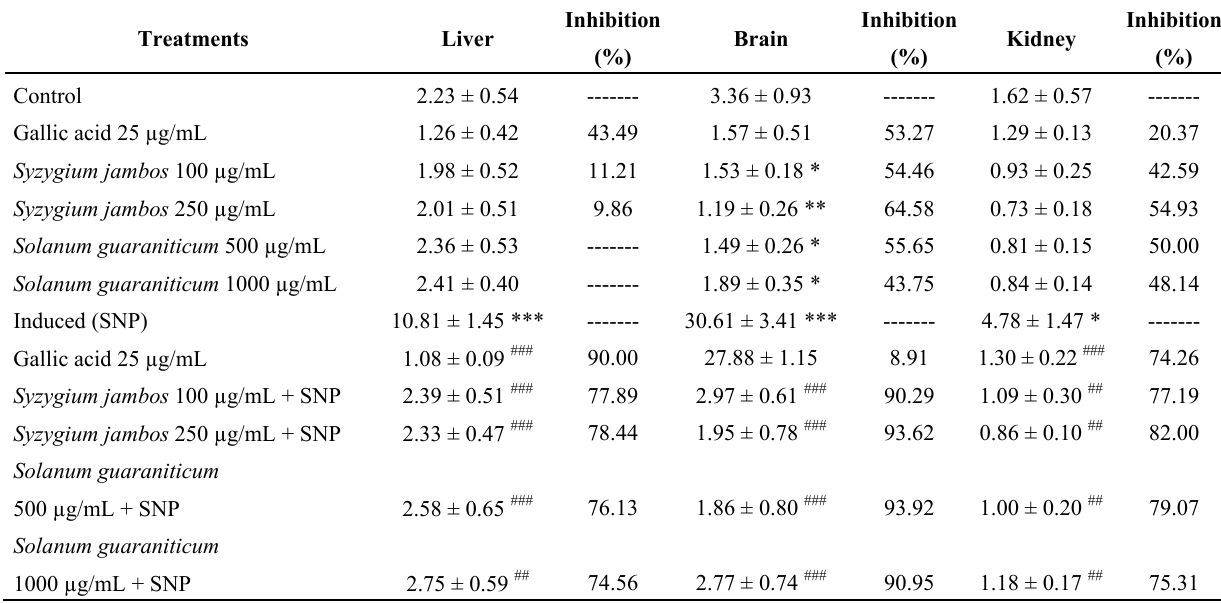
Table 3. Effect of aqueous extracts of Syzygium jambos and Solanum guaraniticum on lipid peroxidation level before and after sodium nitroprusside (SNP) incubation of rat